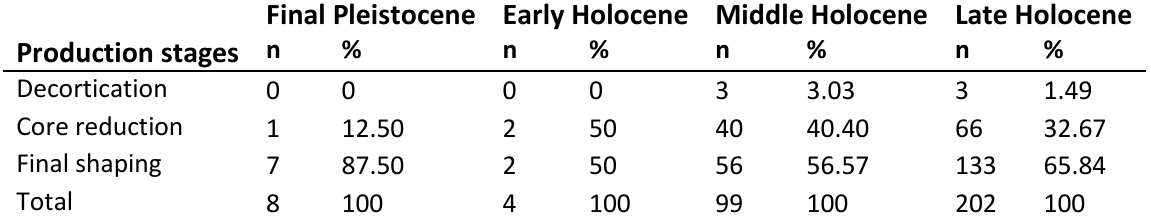
Table 5. Frequency of artifacts according to reduction